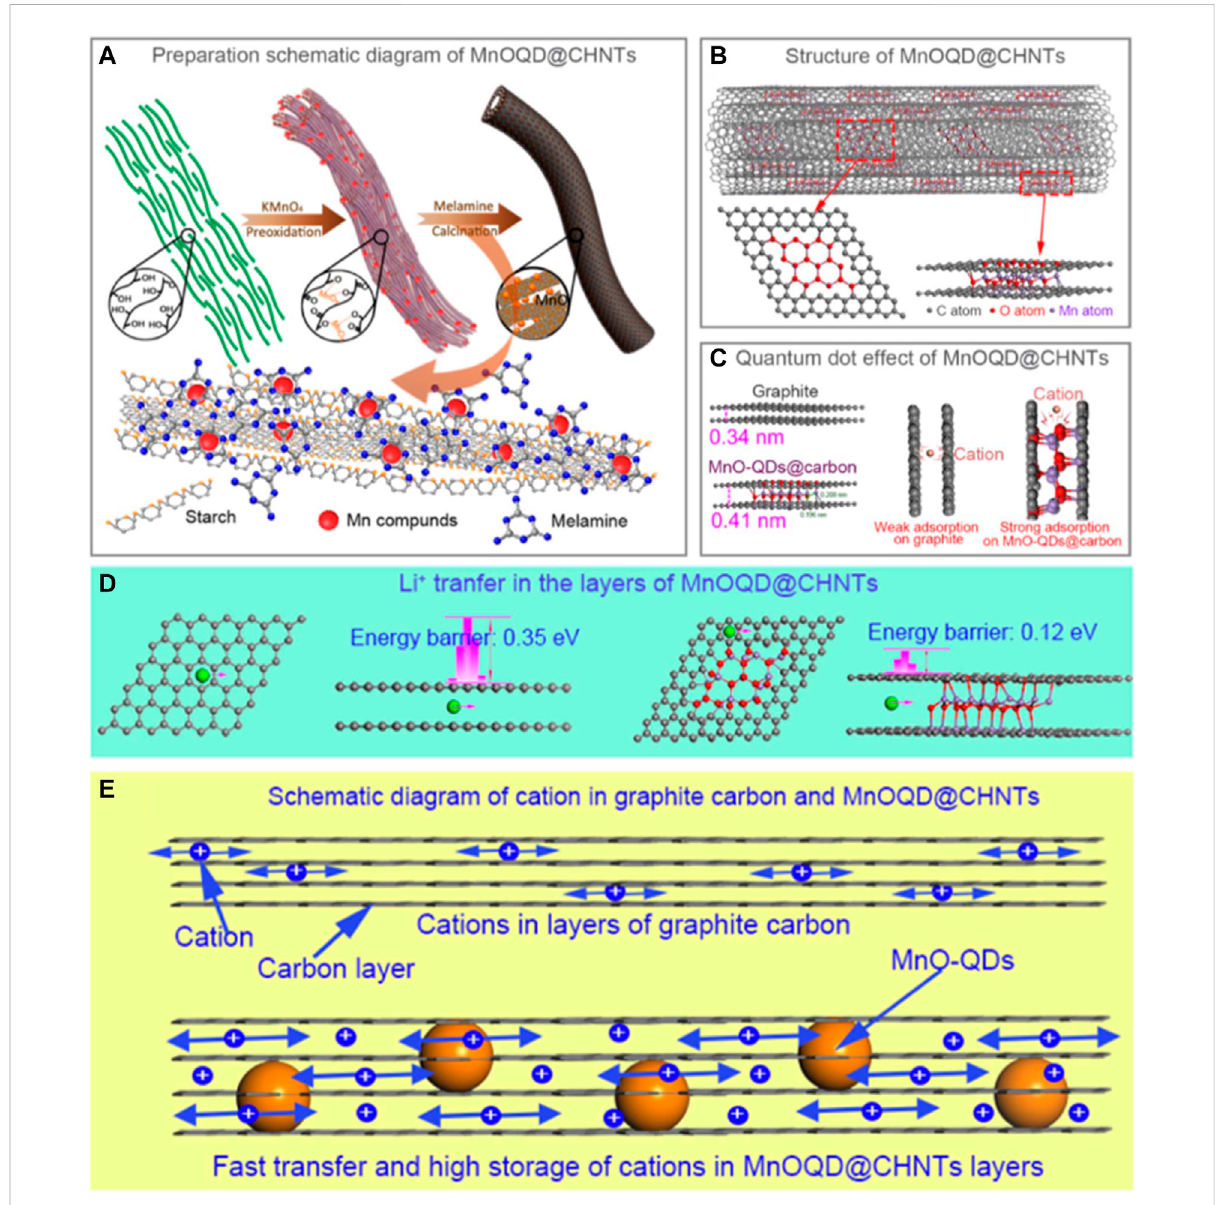
FIGURE 1 (A) Preparation schematic diagram, (B) structure and (C) quantum dot effect of MnOQD@CHNTs; (D) Energy barriers of Li + ion migrating in the layersofgrapheneandMnOQD@CHNTs; (E) SchematicdiagramrepresentsthatcationscanbestronglyadsorbedandrapidlytransportinMnOQD@ CHNTs. Copyright from Elsevier (Li et al.,